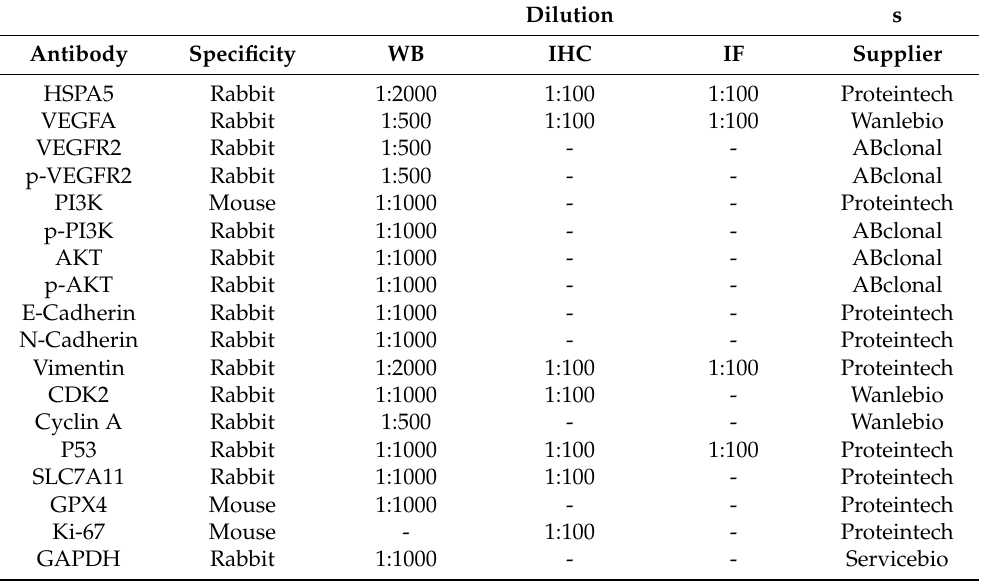
Table 2. Primary antibodies applied in our